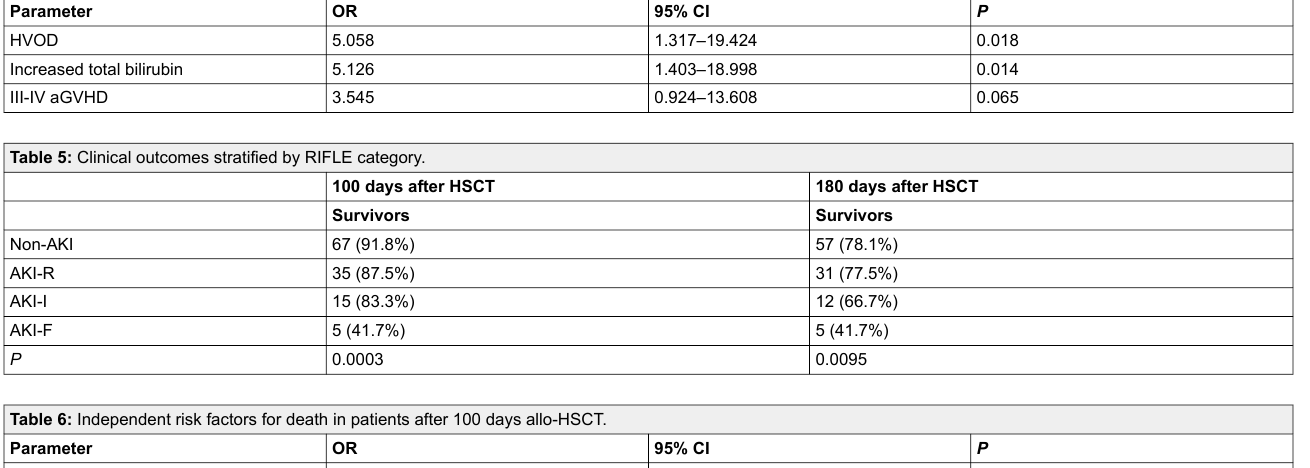
Table 4: Independent risk factors for AKI-F in patients after allo-HSCT. Parameter